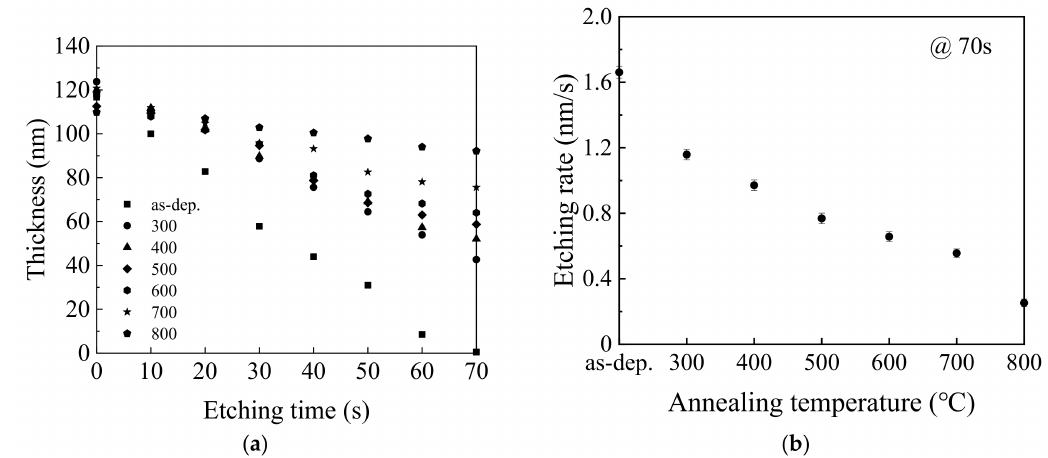
Figure 5. ( a ) Thickness of the RP-ALD SiO 2 thin films at various annealing temperatures after immersing in diluted HF acid; ( b ) etching rate of the RP-ALD SiO 2 thin films during the 70